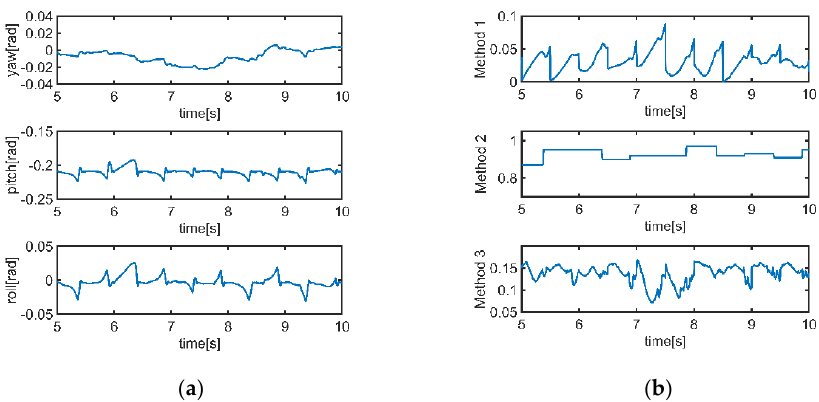
Figure 30. ( a ) Attitude angles; and ( b ) stability measurements of Simulation 3.